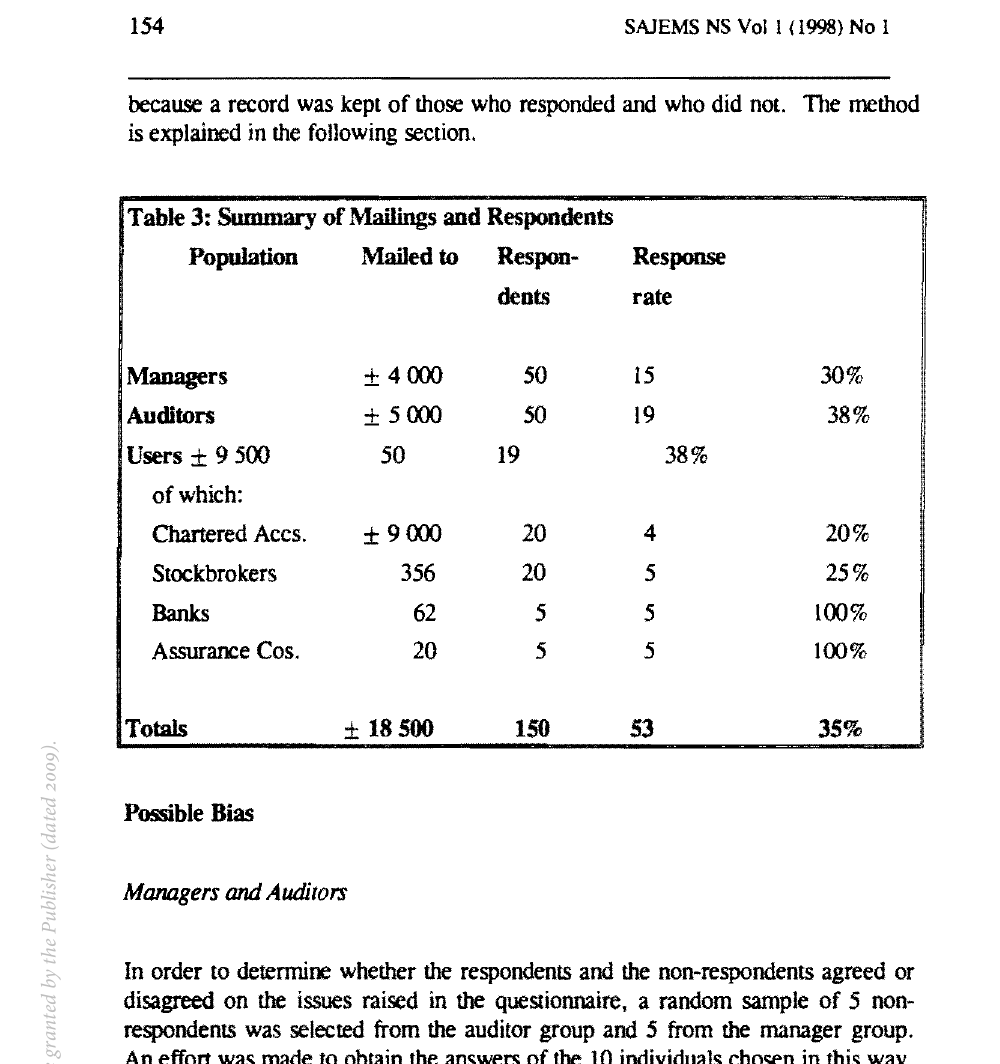
Table 3: Summary of Mailings and